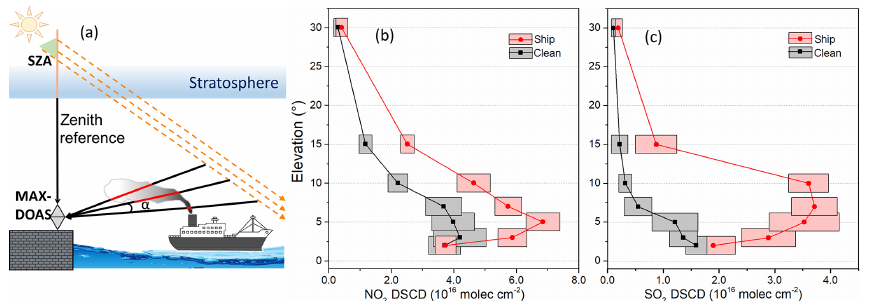
Figure 3. (a) A schematic diagram of the MAX-DOAS measurement geometry for monitoring ship emissions, and the distributions of (b) NO 2 and (c) SO 2 DSCDs with elevation angle on 29 June 2018.